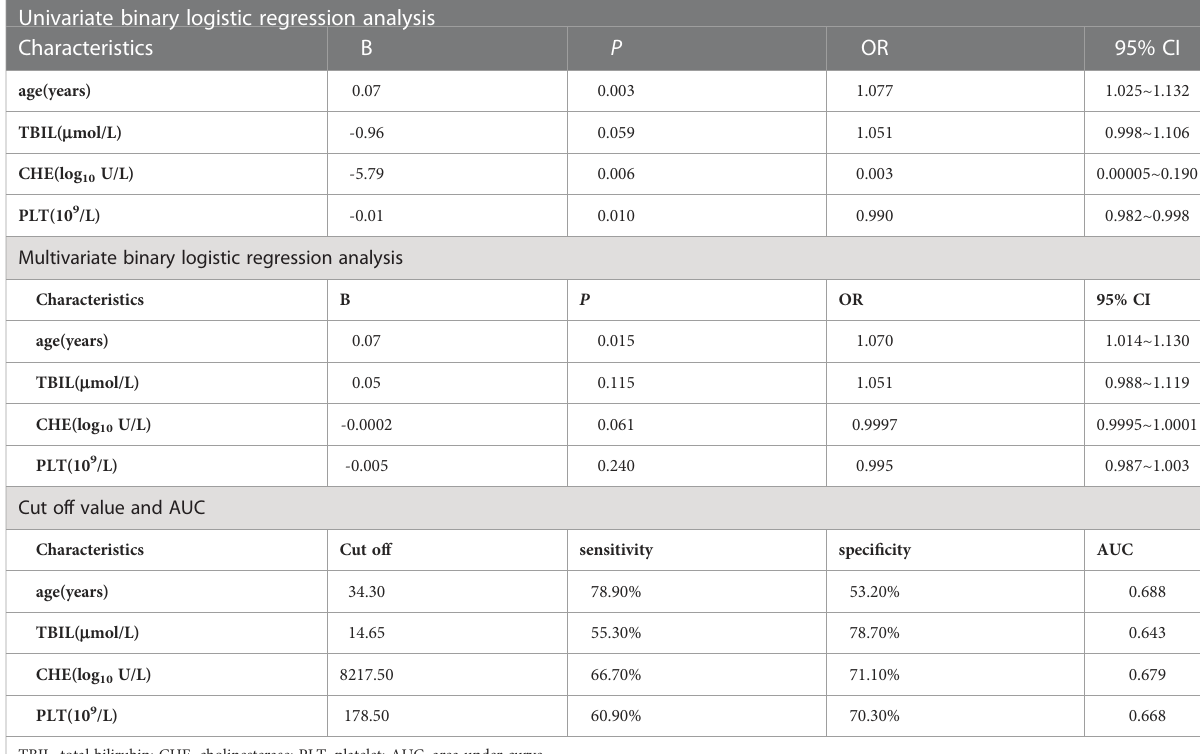
TABLE 4 Logistic regression analysis of HBeAg-negative, HBV DNA-negative patients with and without signi fi cant hepatic